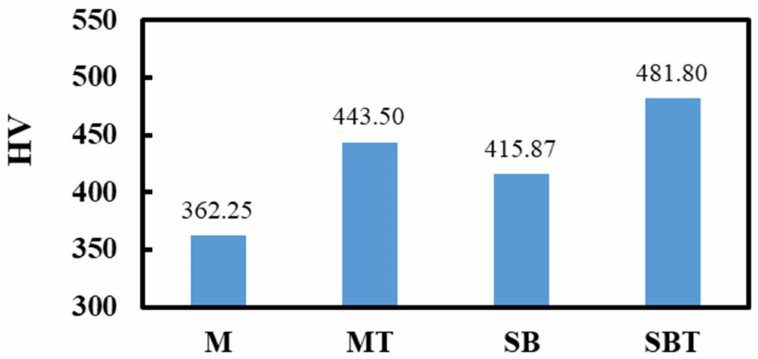
Figure 6. Microhardness of pretreated and treated Ti64 alloy at different